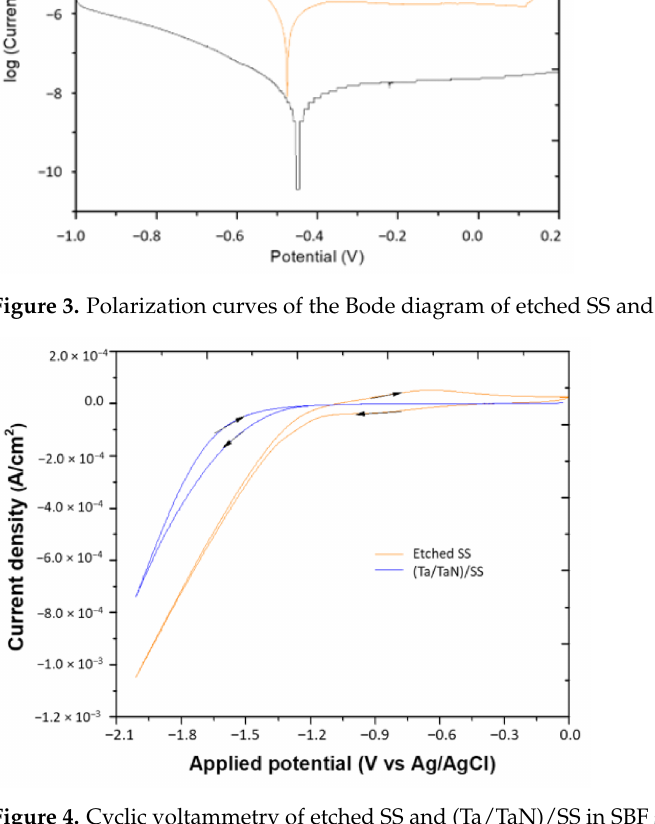
Figure 4. Cyclic voltammetry of etched SS and (Ta/TaN)/SS in SBF solution, at 37 ◦ C, pH de 7.2–7.4. Table 1. Applied potentials for